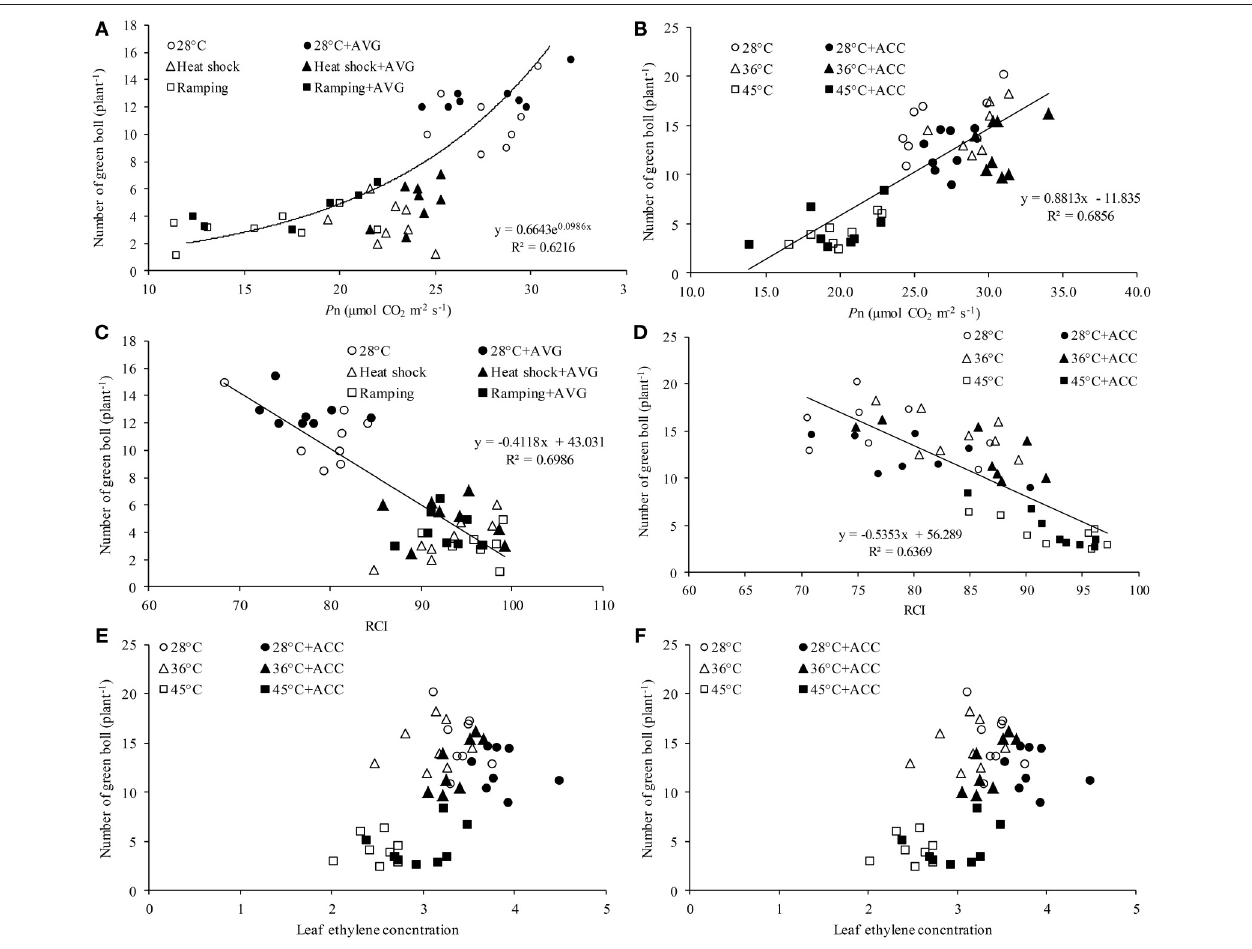
FIGURE 6 | Relationship between green bolls and various physiological attributes of cotton genotypes under varying temperatures and chemical treatments. Relationship between green bolls and leaf photosynthesis ( P n ) of (A) genotypes Sicot 71BRF and 5B treated with 0 or 0.8mM aminoethoxyvinylglycine (AVG) and (B) genotypes Sicot 71BRF and CIM 448 treated with 0 or 20 µ M 1-aminocyclopropane-1-carboxylic acid (ACC). Relationship between green bolls and relative cell injury (RCI) of (C) genotypes Sicot 71BRF and 5B treated with 0 or 0.8mM AVG and (D) genotypes Sicot 71BRF and CIM 448 treated with 0 or 20 µ M ACC. Relationship between green bolls and ethylene concentration in the leaf tissues of (E) genotypes Sicot 71BRF and 5B treated with 0 or 0.8mM AVG and (F) genotypes Sicot 71BRF and CIM 448 treated with 0 or 20 µ M